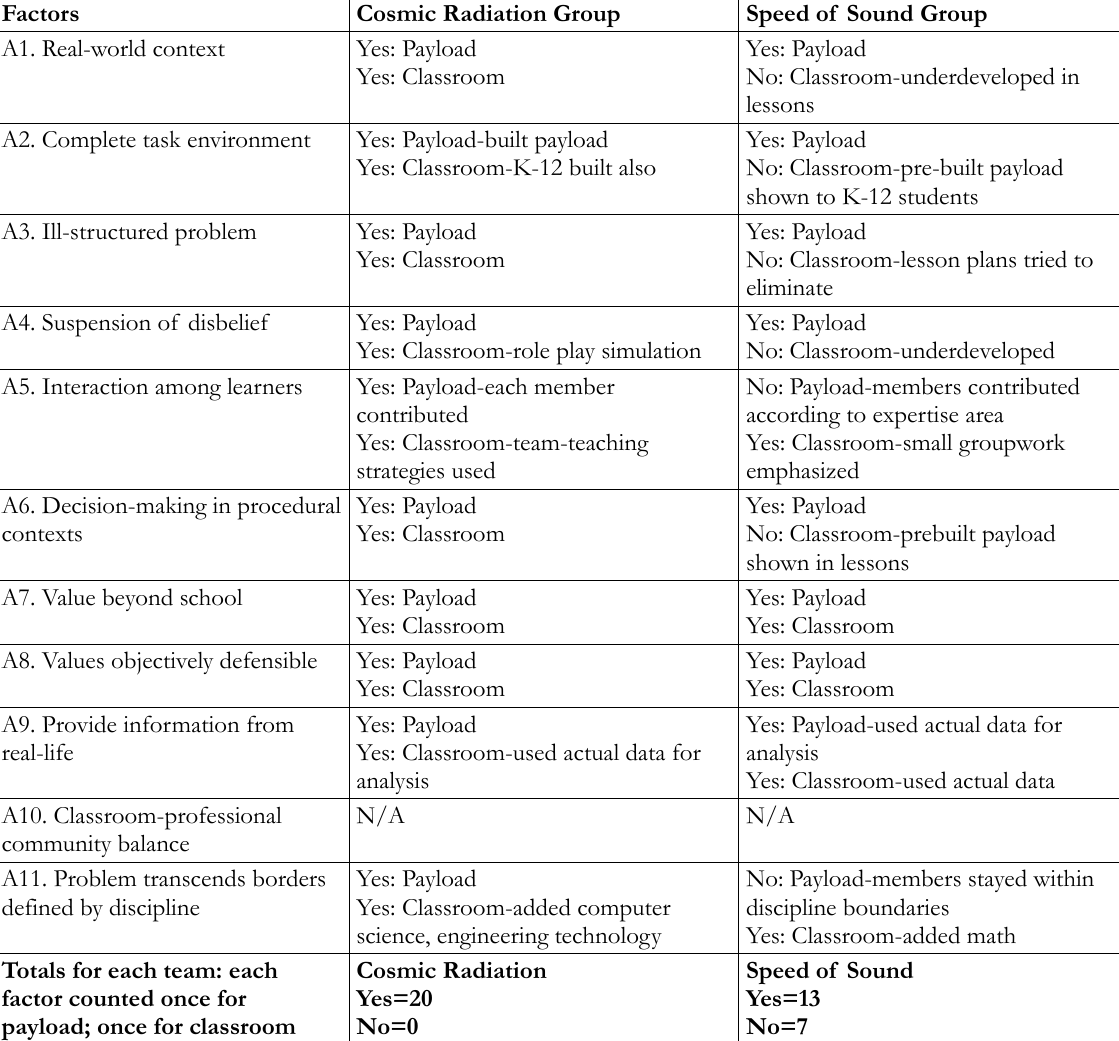
Table 3. Assessment of teams according to authenticity